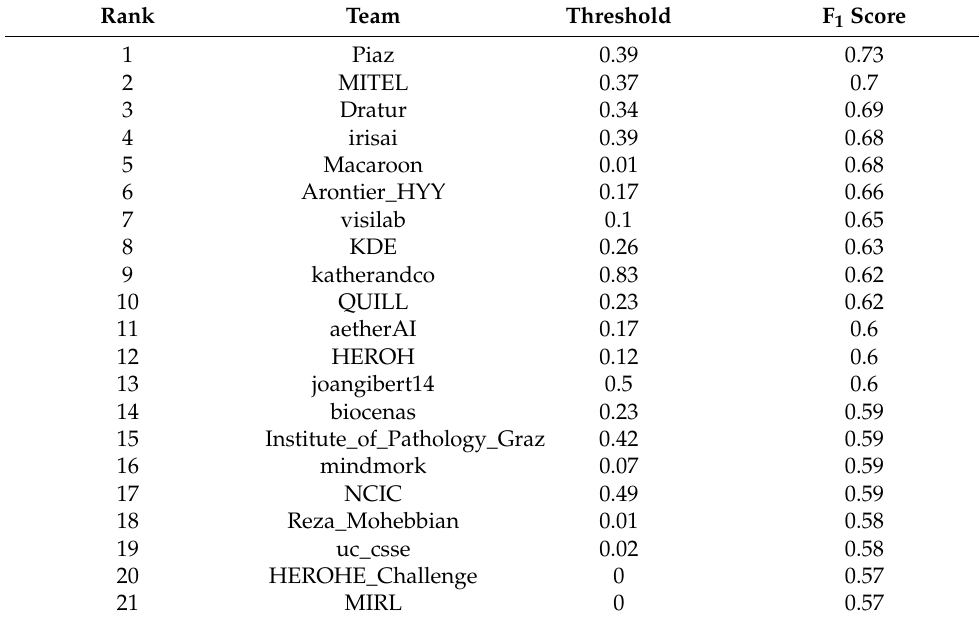
Table 4. Classification of the HEROHE Challenge when the best possible threshold for the test dataset is used. Rank